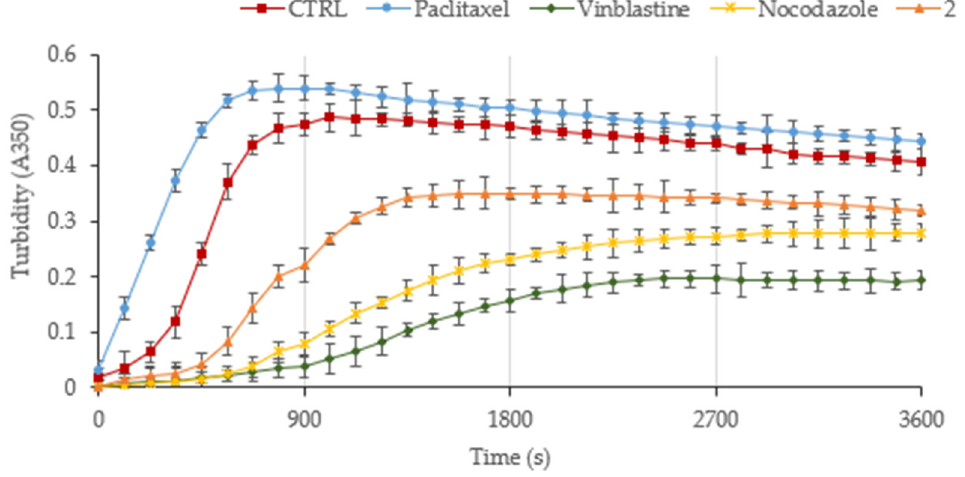
Figure 5. Effects of derivative 2 on tubulin polymerization. The effect of the derivative 2 on in vitro tubulin polymerization was evaluated by recording the turbidity difference at 350 nm for 3600 s (see the experimental section for further details). Paclitaxel was used as a tubulin-stabilizing agent, while Vinblastine and Nocodazole were used as tubulin-destabilizing agents. The three reference molecules and the derivative 2 were tested at the concentration of 10 µM. DMSO was used as a negative control. The graphics are representative of three separated tests; standard deviations (SDs) are shown.